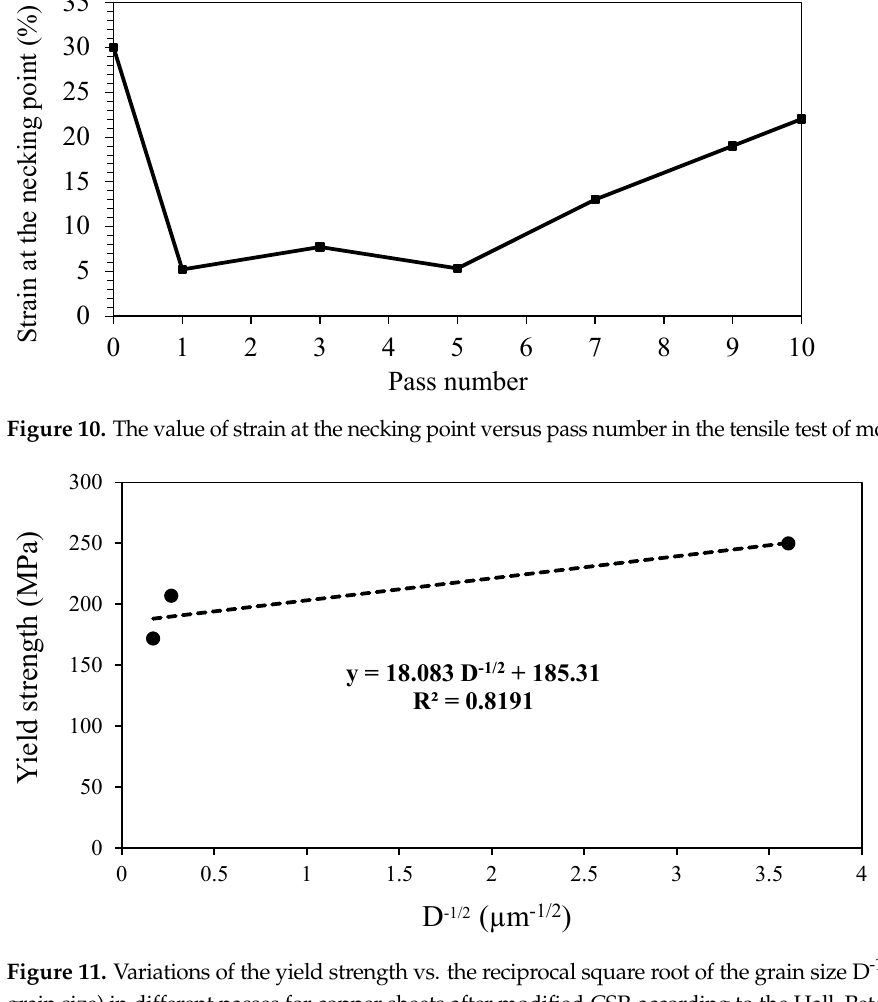
Figure 11. Variations of the yield strength vs. the reciprocal square root of the grain size D ‐ 1/2 (D is grain size) in different passes for copper sheets after modified-CSP, according to the Hall–Petch the grain size)”in different passes for copper sheets after modified ‐ CSP, according to the Hall–